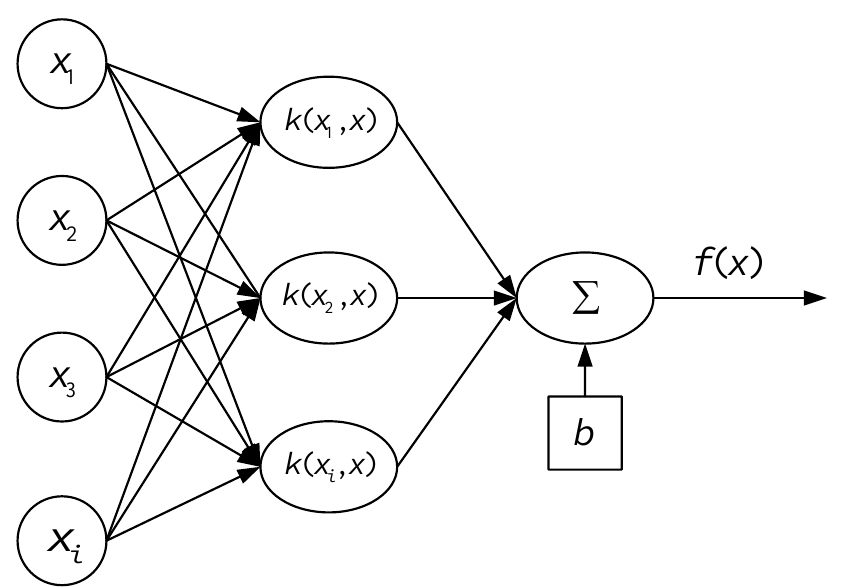
Figure 4. The SVM classification